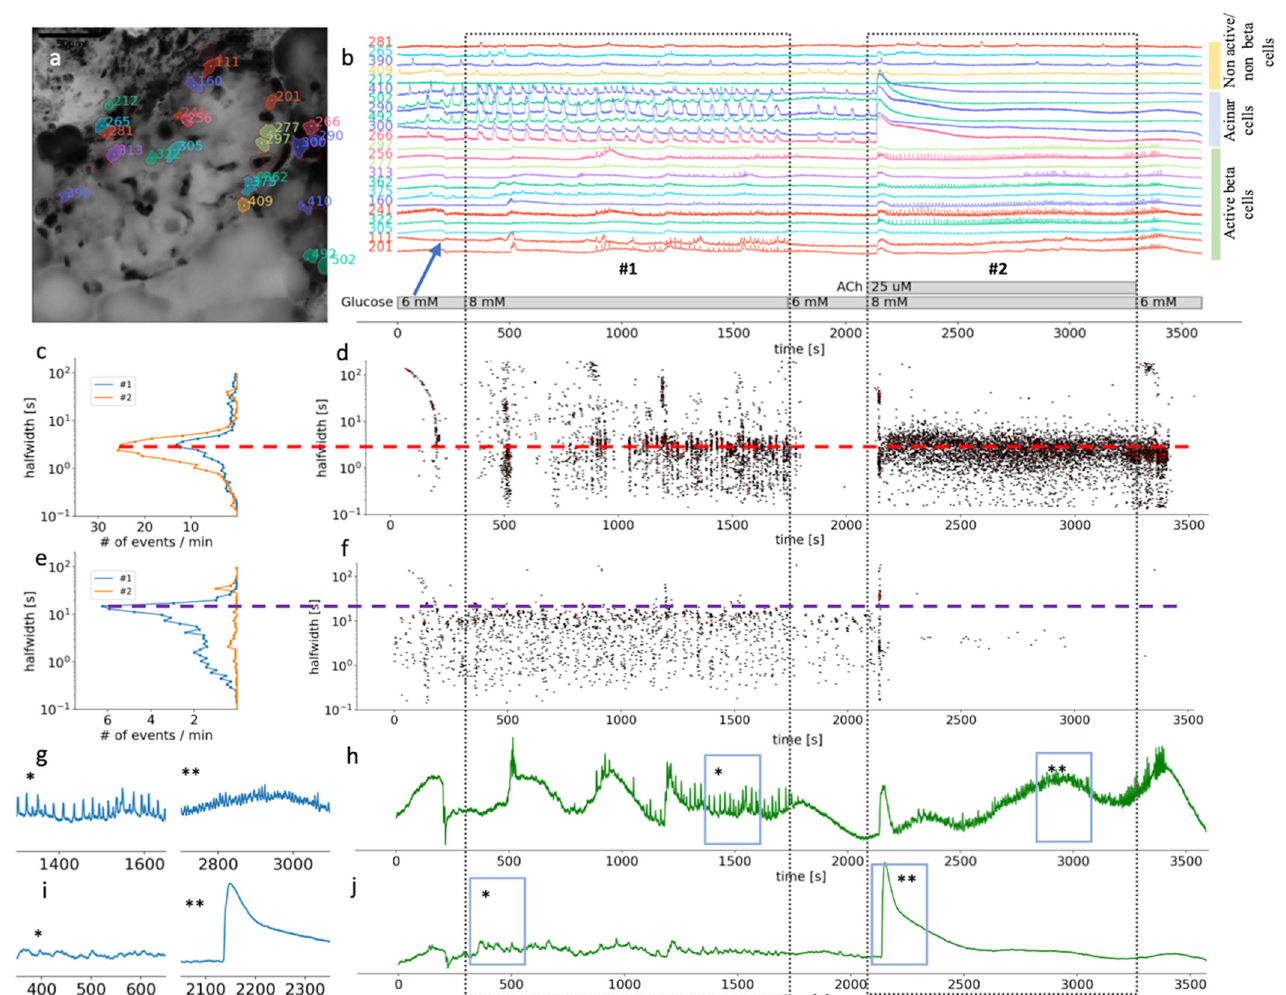
Figure 3. Time scales and heterogeneity of responses of cytosolic Ca 2+ oscillations in mouse beta and acinar cells stimulated with 8 mM glucose or 8 mM glucose plus 25 µM ACh. ( a ) Localization of several beta, acinar and non-active beta on non-beta cell in pancreas tissue slices. ( b ) Temporal profile of the [Ca 2+ ] c changes in a beta, acinar and non-active beta on non-beta cells shown in pancreas tissue slice in ( a ). The two dashed rectangles stretching across the panes indicate the periods of stimulation. ( c ) The frequency histogram of the halfwidth durations of the events and ( d ), onset time of the [Ca 2+ ] c events at measured time scales for active beta cells ( n = 113). Addition of 25 µM ACh increased the frequency of the [Ca 2+ ] c events, the dominant halfwidth duration stayed unchanged (red dashed line). ( e ) The frequency histogram of the halfwidth durations of the events in acinar cell and ( f ), onset time of the [Ca 2+ ] c events at measured time scales for functional regions of acinar cells ( n = 33). Addition of 25 µM ACh abolished [Ca 2+ ] c oscillations of the dominant scale (violet dashed line). ( g ) Expanded time traces of an average from all ROIs specify as active beta cell shown in ( h ) ( n = 113). ( h ) (*) is indicating plateau phase of the response to glucose stimulatory concentration. (**) is indicating fast events in plateau phase during stimulation with 25 µM on top of the 8 mM glucose in panel. ( i ) Expanded time traces of an average from all ROIs correspond to functional regions of acinar cells ( n = 33), shown in ( j ). (*) is indicating average [Ca 2+ ] c events during stimulation with 8 mM glucose. (**) is indicating average [Ca 2+ ] c events during stimulation with 25 µM ACh on top of the stimulatory glucose concentration. Blue arrow on ( b ) is indicating an artefact due to a transient slice movement that occurred during imaging and was detectable in multiple time traces.